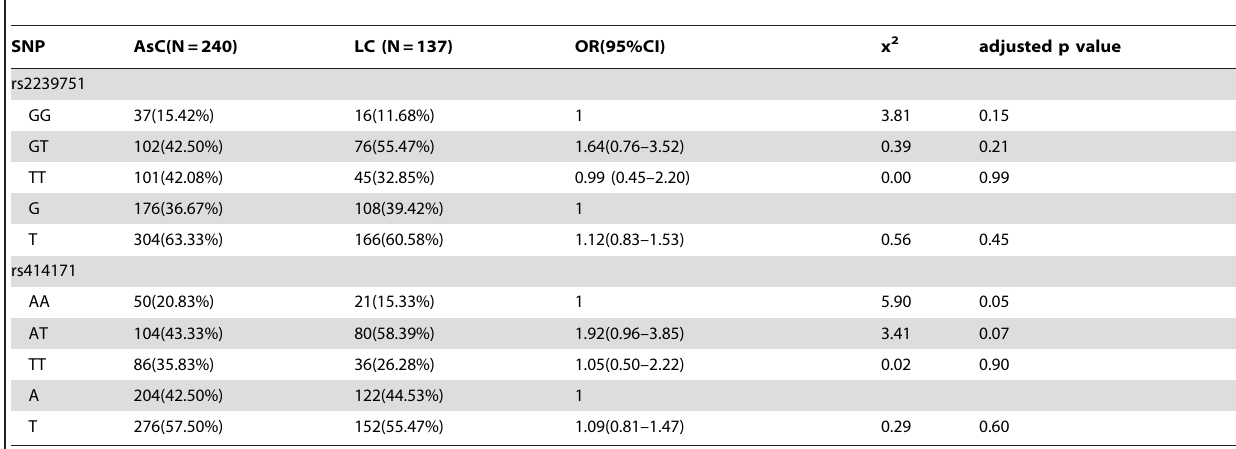
Table 5. Genotype and allelic distribution for CISH gene polymorphisms when AsC group was compared to LC